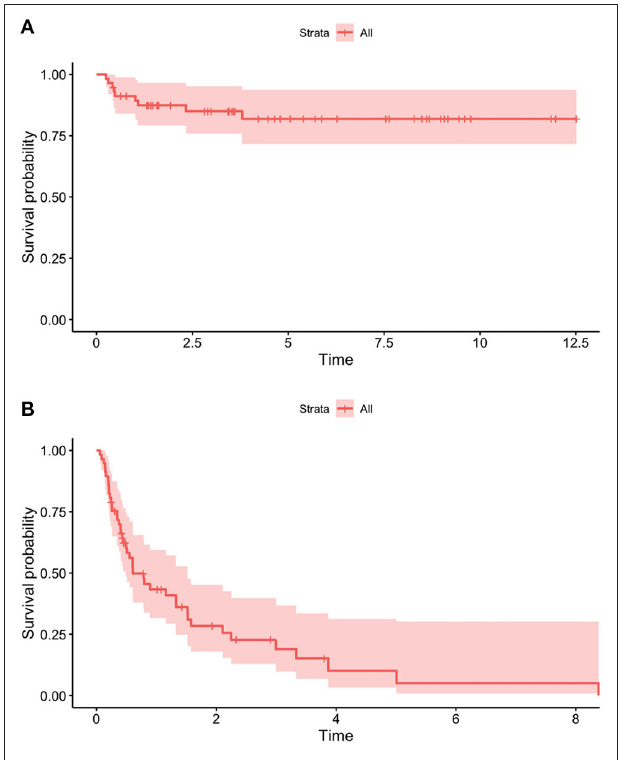
FIGURE 7 | Different survival (A) and dependence (B) rates of patients on HPN because of secondary CIF, based on the underlying disease.